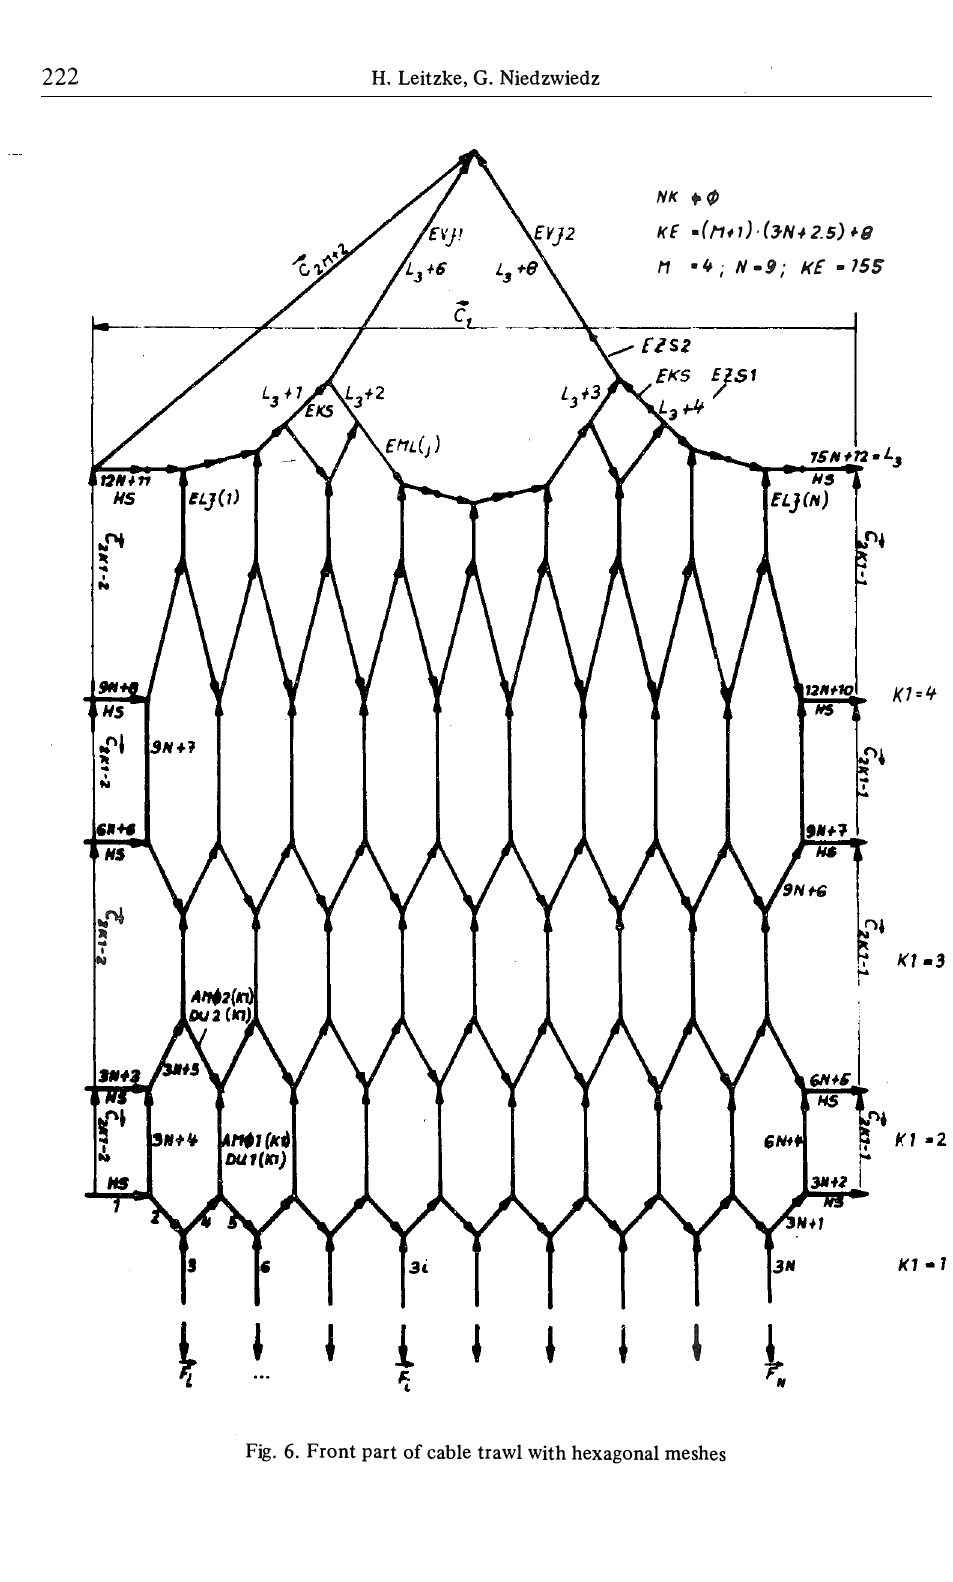
Fig. 6. Front part of cable trawl with hexagonal